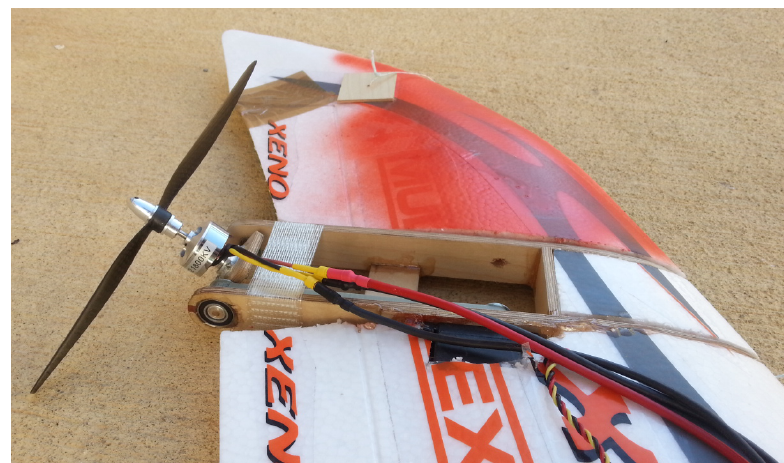
Figure 7. Xeno UNI form Multiplex with two customised tilt rotors.